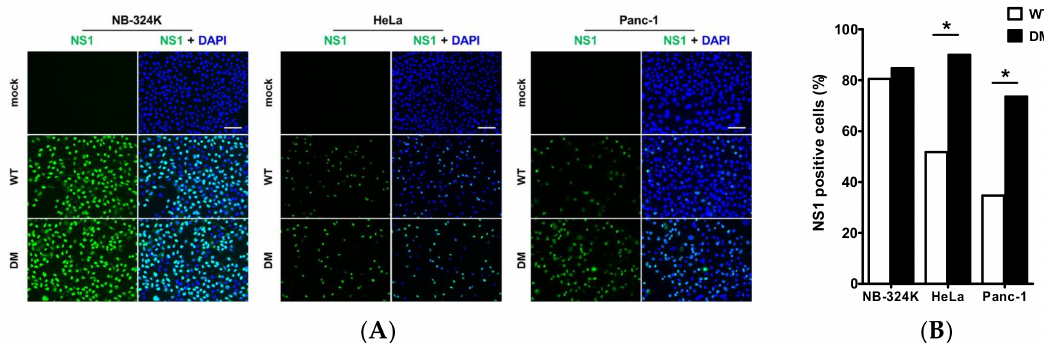
Figure 3. Increased efficiency of infection of H1-DM in various human cell lines. ( A ) Indirect immunofluorescence of NS1 after infection of NB-324k, HeLa, and Panc-1 cells. Cells (4 × 10 3 ) were mock-treated or infected with wt H1PV or H1-DM (MOI, 10 PFU/cell) and analyzed at 24 h p.i by indirect immunofluorescence assay for NS1 (green). Nuclei were visualized by co-staining with DAPI (blue) in merge panels, 20x magnification, scale bar = 100 µ m; ( B ) Percentage of NS1-positive cells after infection with wt H-1PV or H1-DM. The percentage of NS1-postive cells in ( A ) was determined by counting at least 200 cells in three distinct fields per sample (* p <